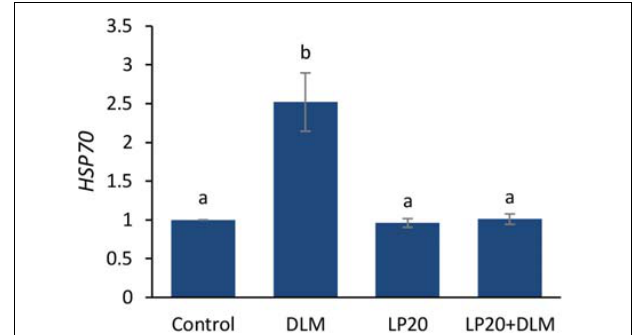
FIGURE 5 | Relative expression of heat shock protein 70 ( HSP70 ) gene of Nile tilapia exposed to DLM and challenged with Aeromonas hydrophila and fed diets with or without LP20 for 30 days. Values are expressed as mean ± SE from triplicate groups (nine fish per group). Bars with different letters indicate significant difference from the control group ( P < 0.05).